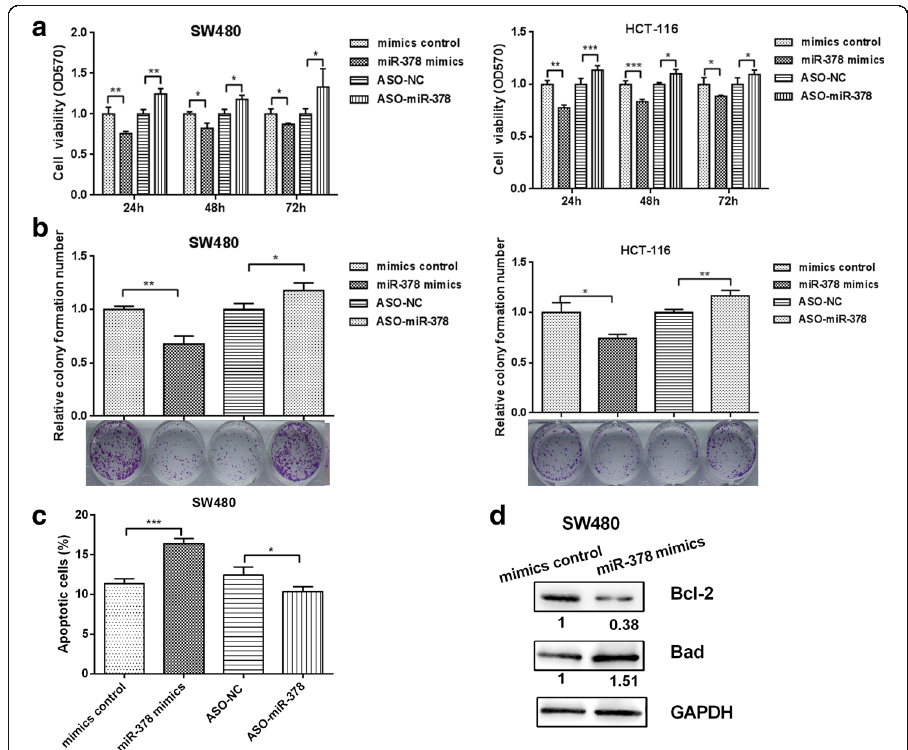
Fig. 2 Influences of miR-378 on the proliferation of colon cancer cells. a The MTT assay was performed to measure the amount of SW480 and HCT-116 cells transfected with miR-378 mimics or ASO-miR-378. b A colony formation assay was performed to detect SW480 and HCT-116 cells transfected with miR-378 mimics or ASO-miR-378. c FACS was performed to determine the level of cell apoptosis when miR-378 was overexpressed or knocked down. d Western blot was used to detect the apoptosis proteins Bad and Bcl-2 in SW480 cells transfected with miR-378 mimics. GAPDH was used as a loading/transfer control and for normalization of the values. * p < 0.05, ** p < 0.01, *** p < 0.001